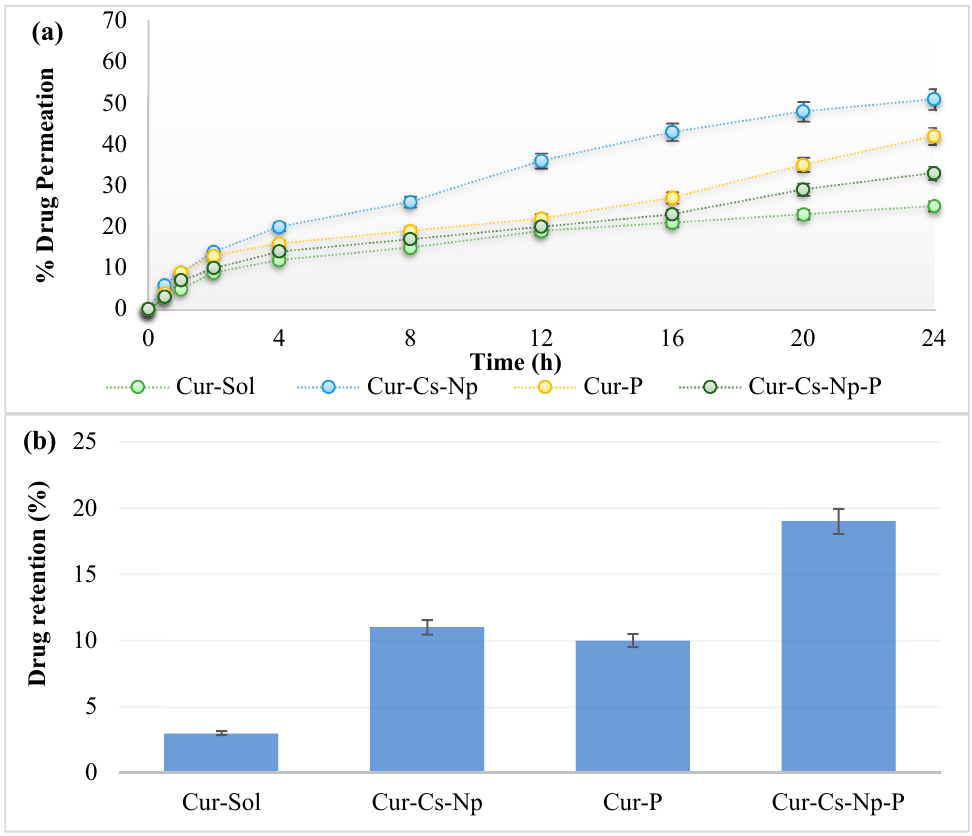
Figure 4. ( a ) Ex vivo permeation and ( b ) Skin drug retention of curcumin.